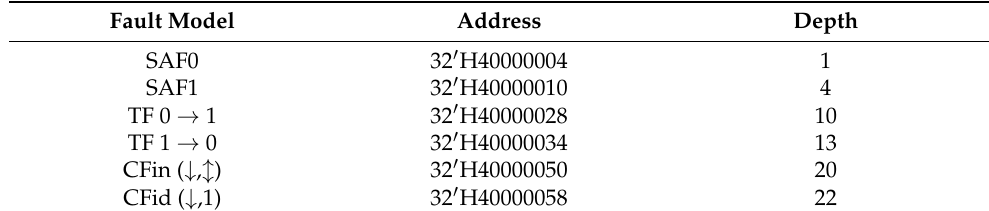
Table 4. Fault model implanted in memory.